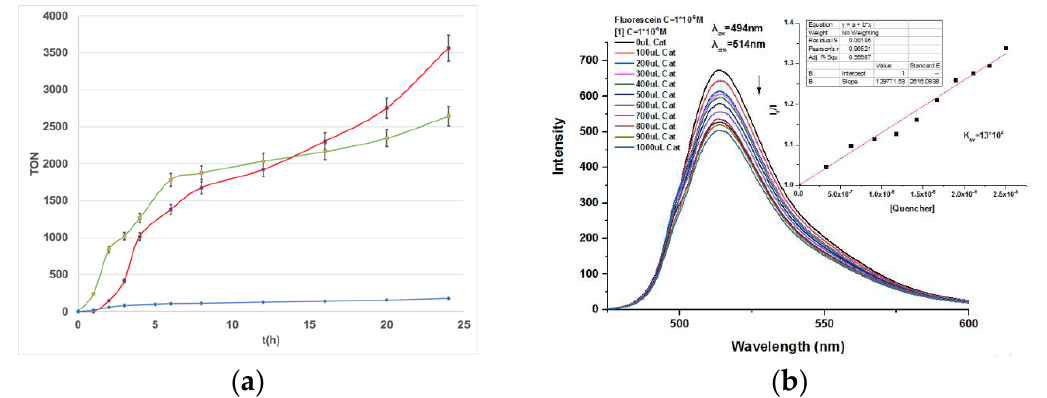
Figure 2. ( a ) Light-driven hydrogen production from system containing complex [1] + as catalyst (8.5*10 −7 M), Fl 0.3 mM, TEOA (0.5 M) in DMF: H 2 O (1:13)(10.0 mL) (green), in DMF: H 2 O (2:8)(10.0 mL) (red) and in H 2 O (blue) ( b ) Photoluminescence spectra of fluorescein as a function of [1] + and Stern-Volmer plot of quenching by [1] +.